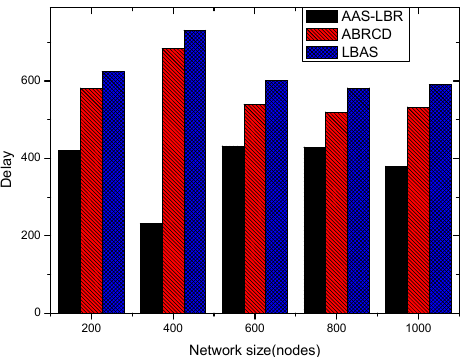
Figure 46. The impact of network size with fixed value of | T | = 150 on the broadcast delay.